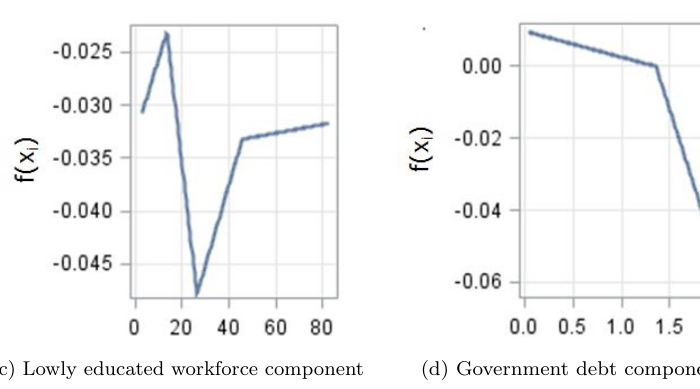
Figure 1: MARS EU28 additive model: dependence of growth on the main four factors, as detected by the